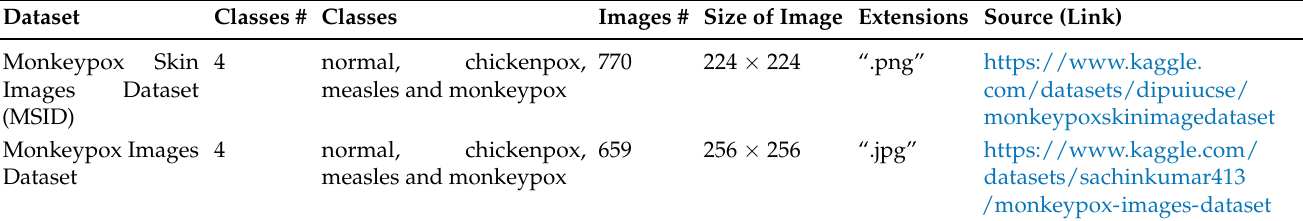
Figure 3. Samples from the datasets that are used in the current investigation. From [44,45]. Table 1. The used datasets